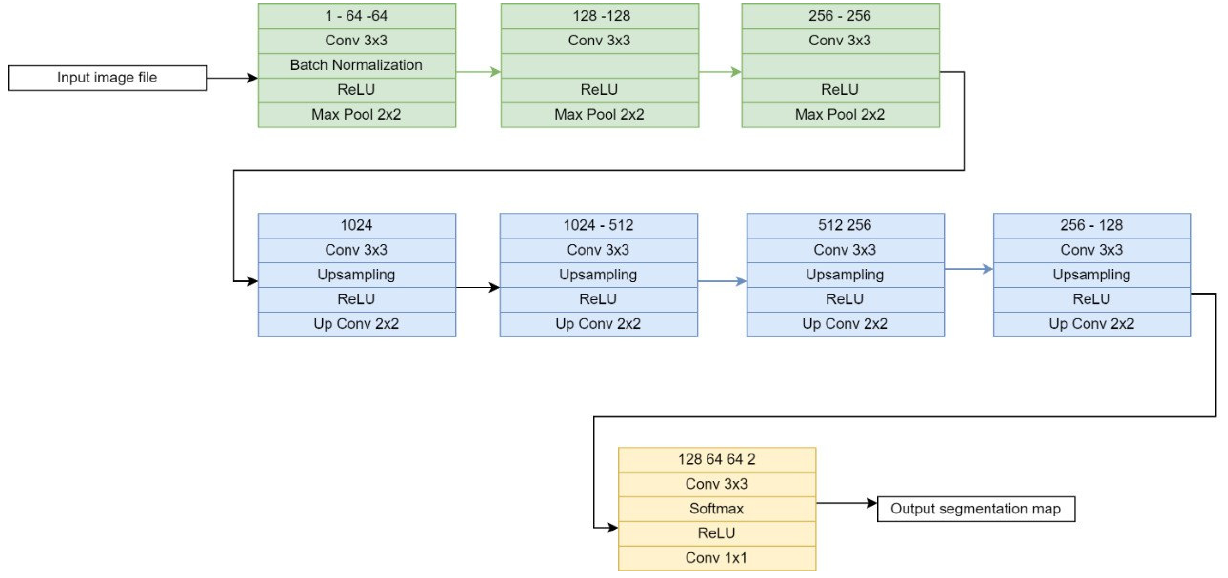
Figure 1. The proposed architecture for the semantic segmentation of webpage images.